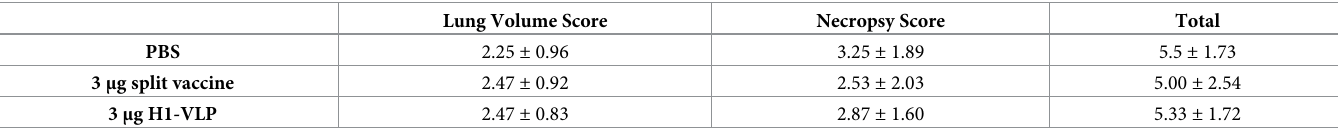
Table 1. Summary of comorbidity scores assessed by necropsy and CT scan after two immunizations of H1-VLP, split-virion vaccine or